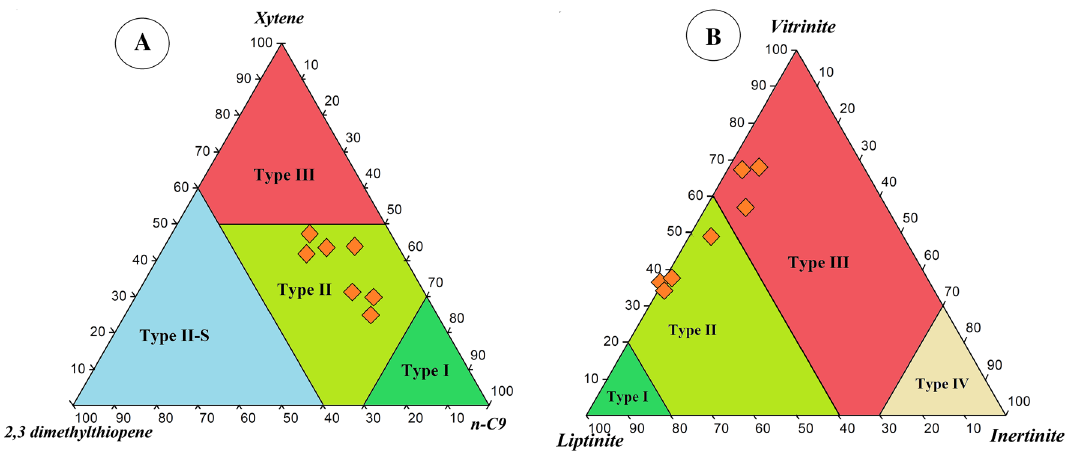
Fig. 11 Ternary diagrams on the kerogen characteristics based on ( A ) the relative percentage of compounds 2, 3-dimethylthiophene, O-xylene (1, 2- dimethylbenzene) and n-non-1-ene (n-C9:1) derived from the n-alkyl chain length distribution in the Py-GC data (see